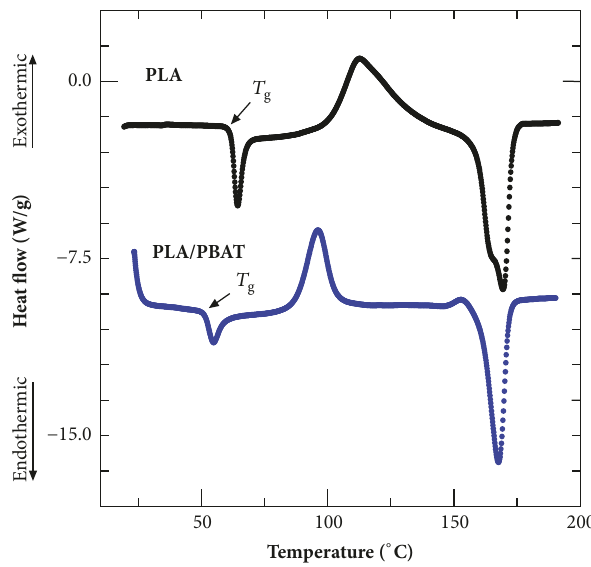
Figure 3: DSC curves of PLA and